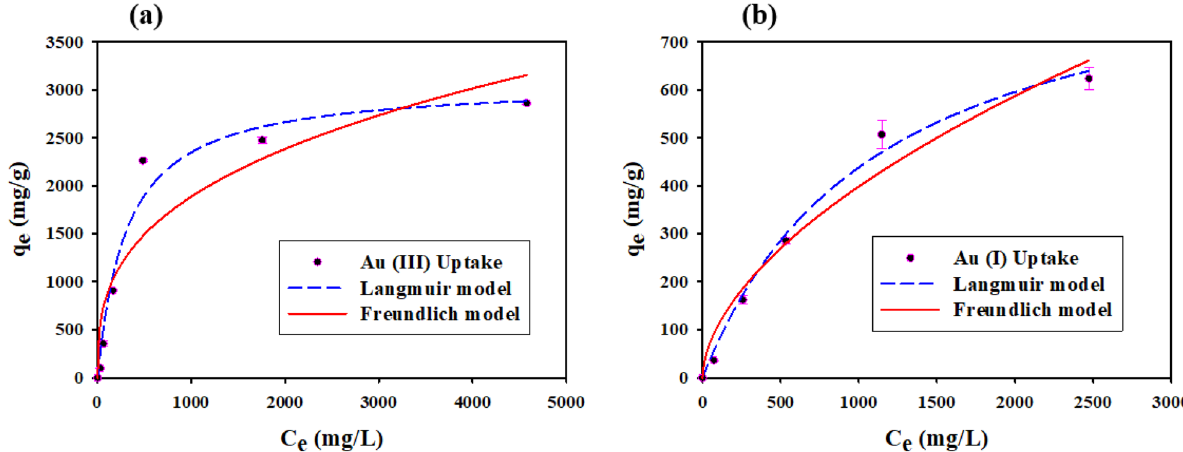
Figure 4. Isotherms of ( a ) Au (III) and ( b ) Au (I) adsorption into the capsule (C 0 = 0–5500 mg/L, pH = 2, t = 24 h, M ads /V sol = 0.4 g/30 mL, T = 25 ± 2 °C).